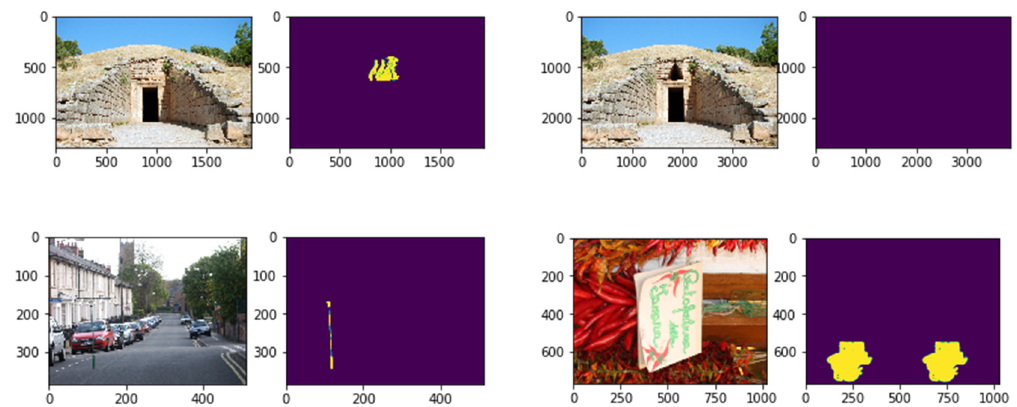
images. The second and fourth columns represent the detection results of the proposed model.